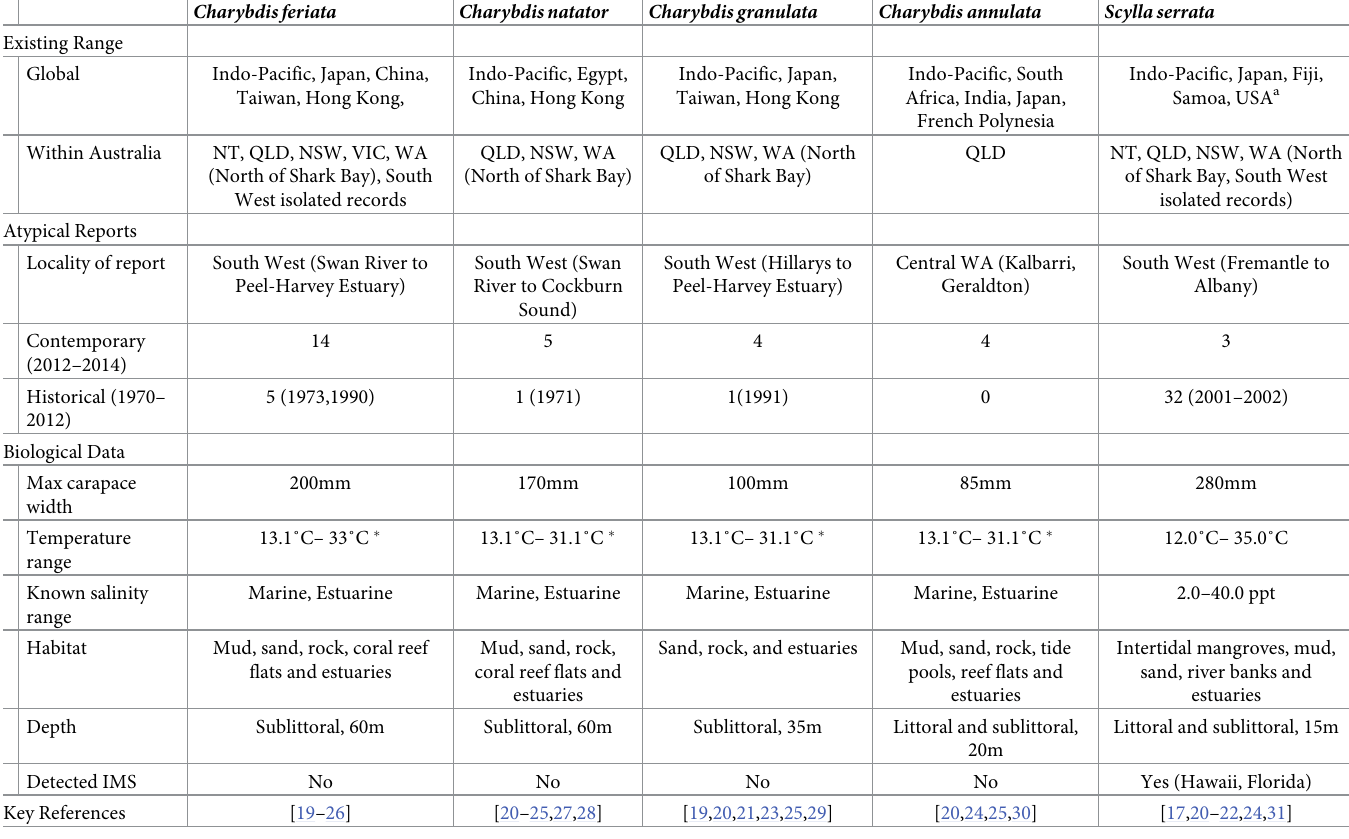
Table 1. Species synthesis table of atypical tropical portunid crab species recorded in South-Western Australia from the 2012–2014 Charybdisjaponica surveillance campaign and from historical records. Known distributions and basic biological data are also presented. Charybdisferiata